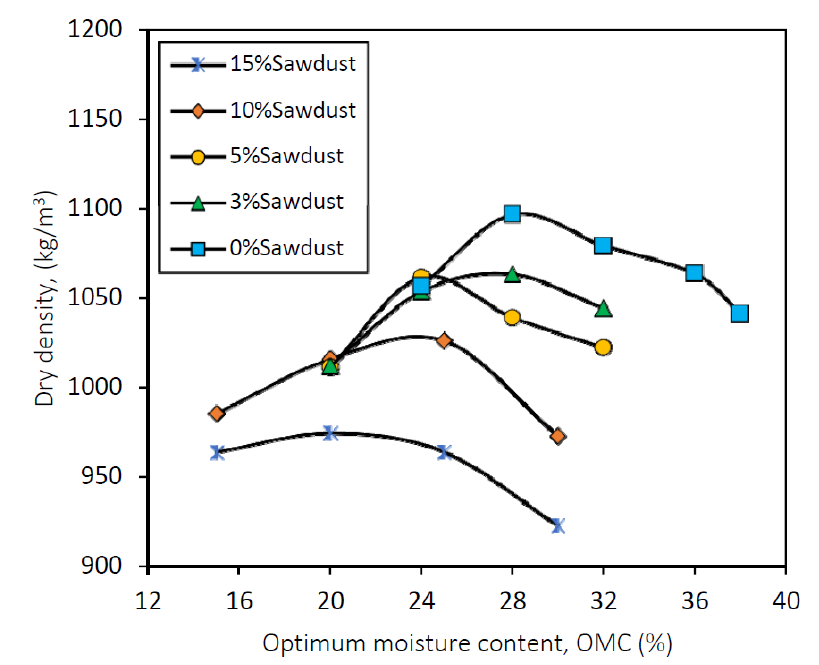
Figure 4. Compaction curves for the used mixtures (i.e., 0%, 3%, 5%, 10% and 15% sawdust).